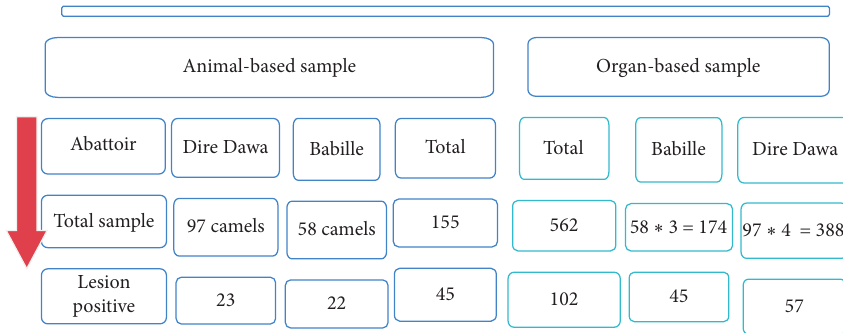
Figure 1: Detail camel- and organ-based pathological sample Table 1: Owners’ knowledge and practices in managing reproductive diseases and reason for culling she-camels at the study area. Productivity testing criteria